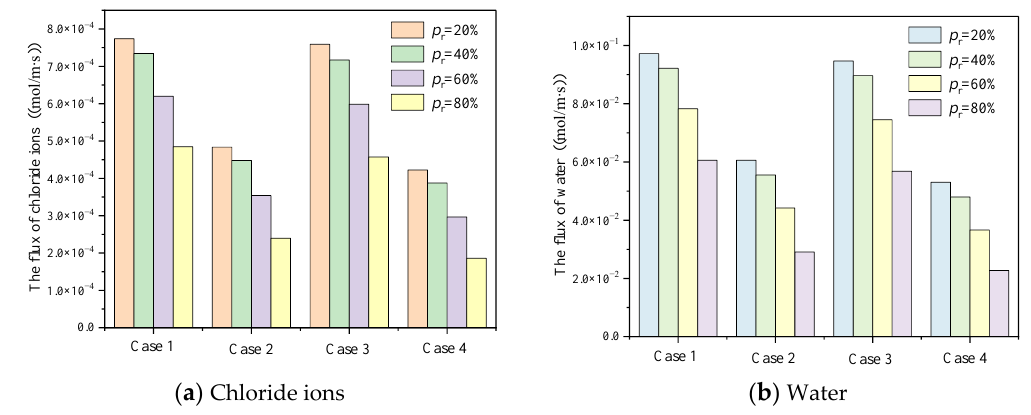
Figure 13. The influence of slippage on diffusion flux on steady state at micron scale.